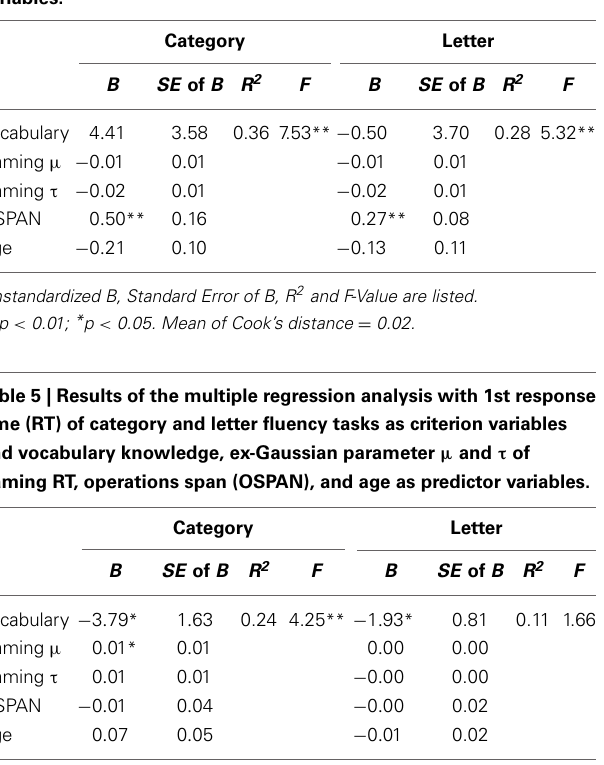
Table 4 | Results of the multiple regression analysis with mean scores of category and letter fluency tasks as criterion variables and vocabulary knowledge, ex-Gaussian parameter µ and τ of naming response time, operations span (OSPAN), and age as predictor variables.